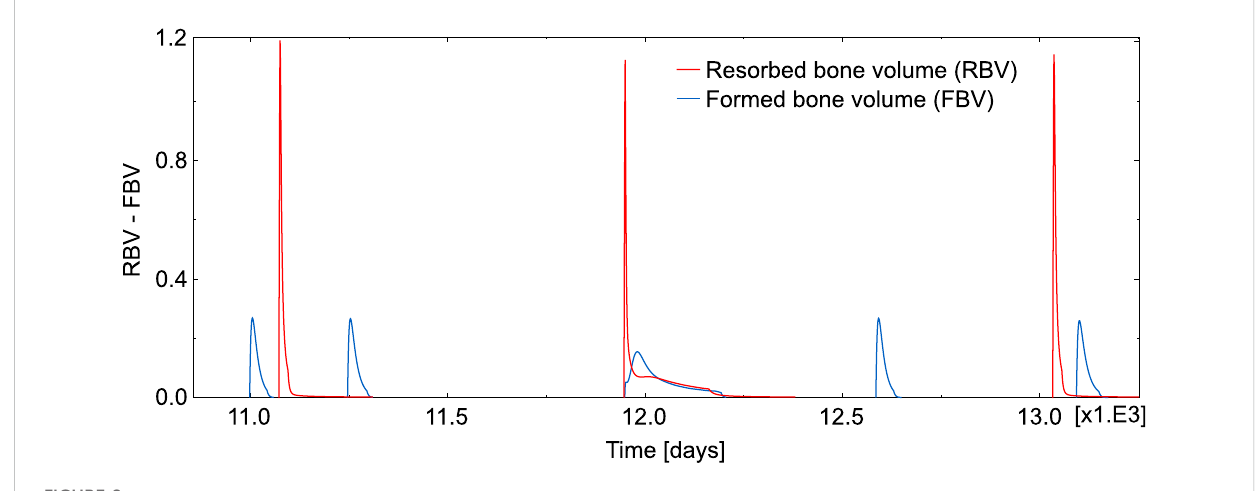
FIGURE 8 TemporalevolutionofRBVandFBVobtainedinoneelementinthecaseofabsenceofTGF- β .Thistimewindowwaschosenforitisrepresentativeof the uncoordinated behaviour observed in the absence of TGF- β , with cycles where formation precedes resorption, isolated cycles, overlapping cycles and also normal cycles.